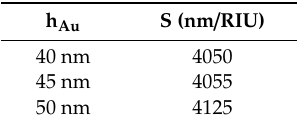
Figure 10. Influence of d c on the loss spectrum with h Au = 50 nm.